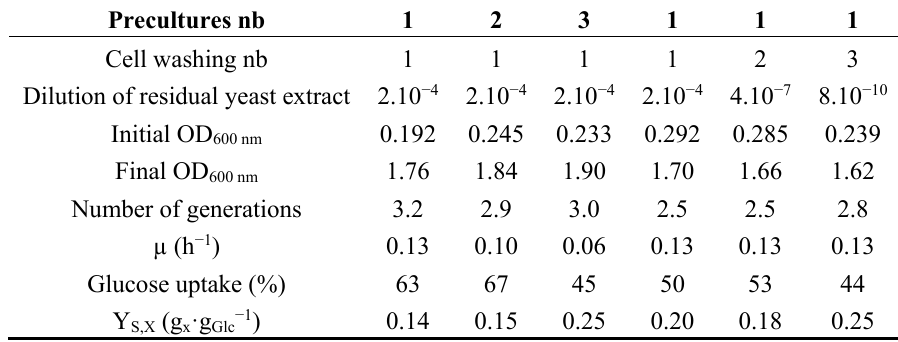
Table 6. Effect of successive subcultures and cell washing steps before inoculation on the results of growth of Deinococcus geothermalis DSM-11302 in